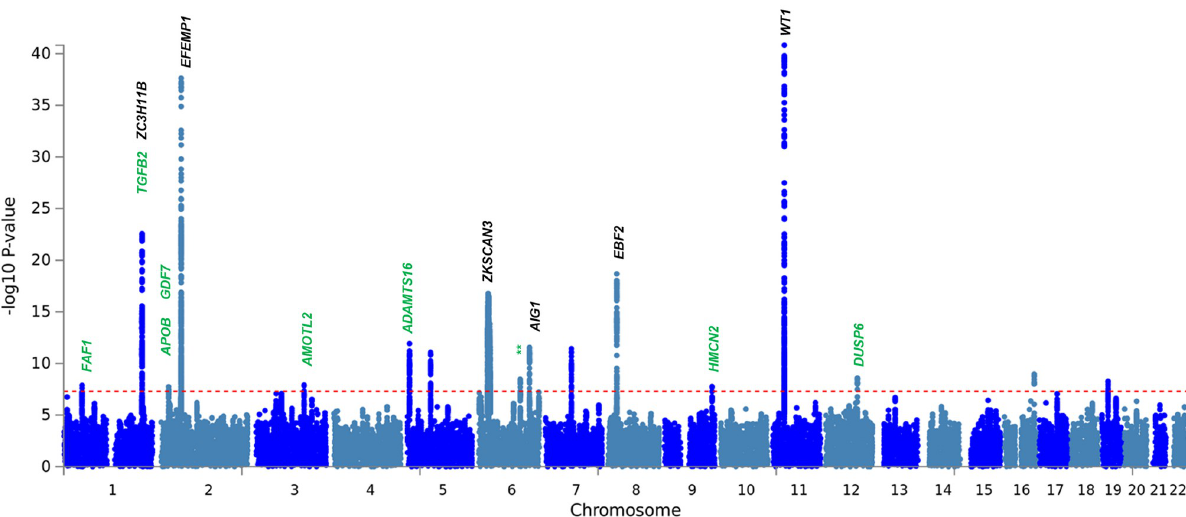
Fig 5. Manhattan plot of the umbrella hernia cohort GWAS analyses. Annotations show the gene names of loci that demonstrated shared susceptibility across two or more individual analyses. The nine loci that were not discovered in the individual or overlap analyses are highlighted with green font or with �� where no gene was prioritised at this